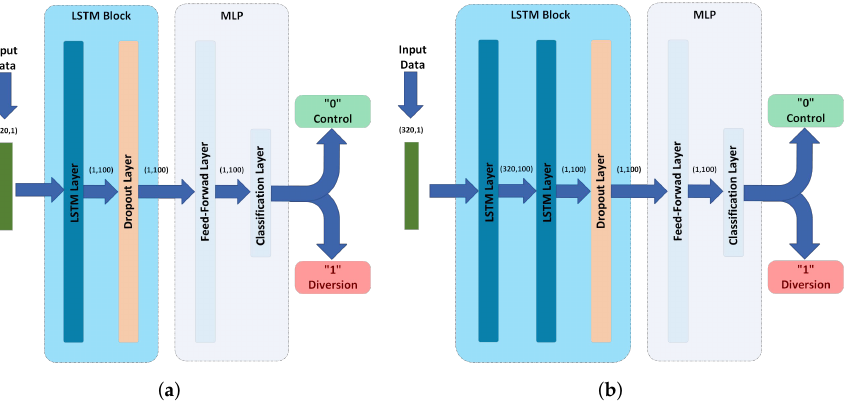
Figure 8. LSTM-based models’ architectures. ( a ) LSTM model. ( b ) 2 Stacked LSTM